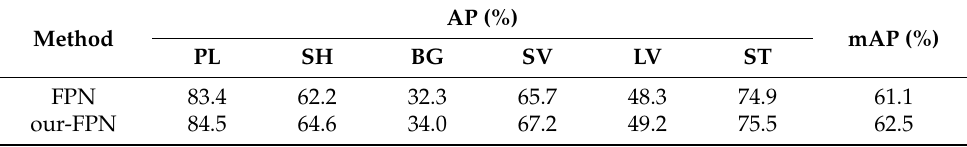
Table 1. The experimental results of the bidirectional multi-scale feature fusion network.